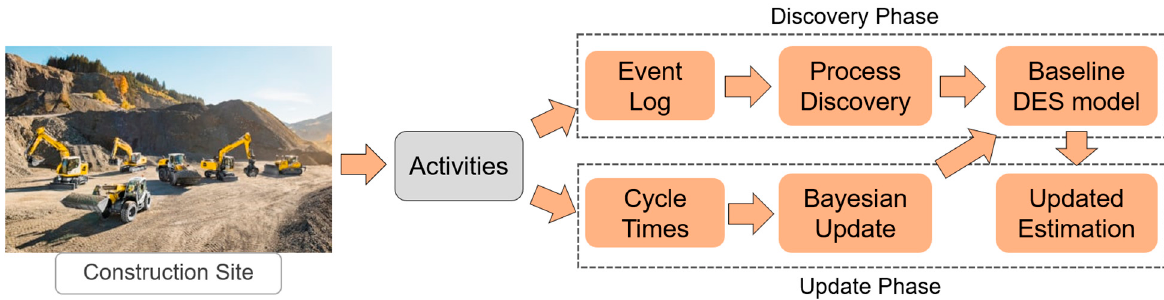
Figure 3. Framework for data-driven decision making.